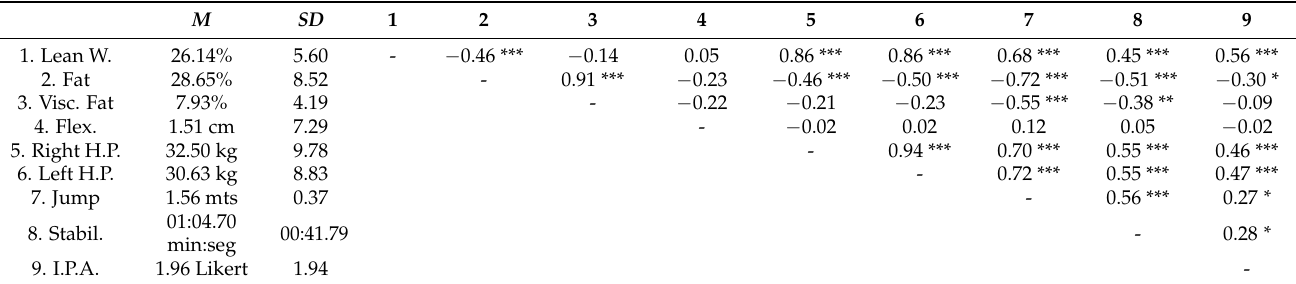
Table 1. Descriptive Statistics and Correlations between Variables (Pre-test).